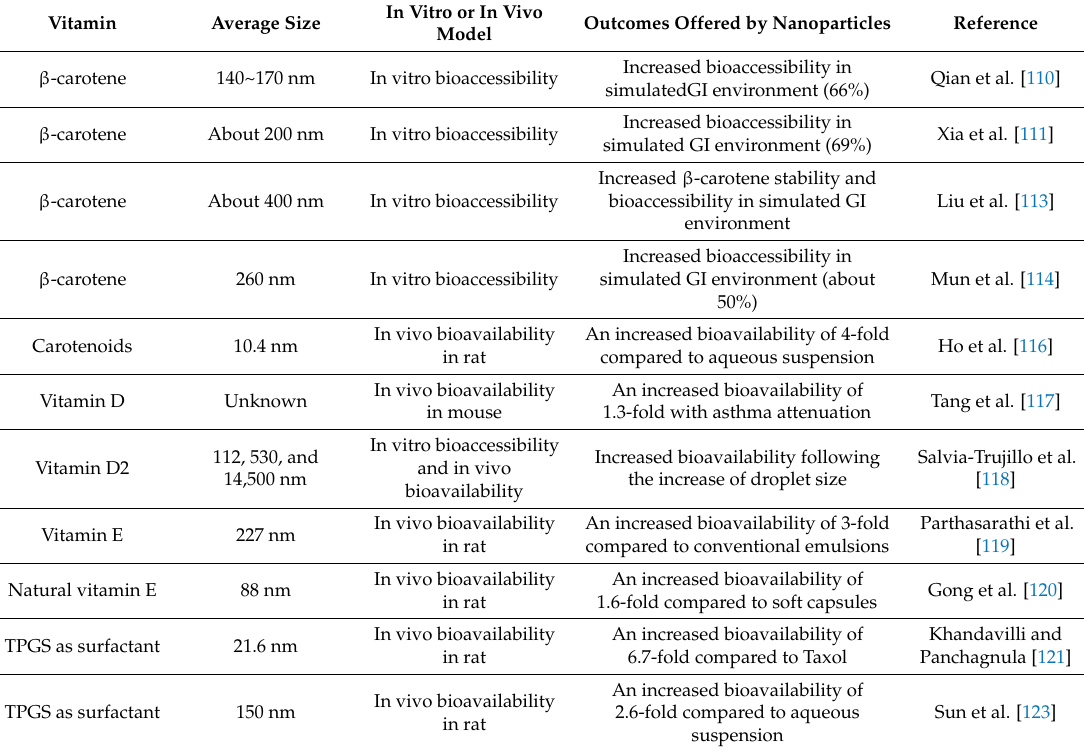
Table 3. Characterization of nanoemulsions and microemulsions loaded with vitamins or their derivatives and their oral